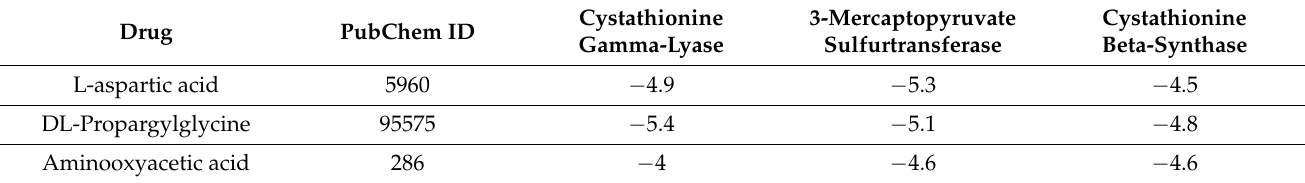
Table 1. The binding energy value (in kcal/mol) of drugs (PAG, L-Asp, and AOAA) to their respective enzymes (CSE, 3-MPST, and AOAA) in the drug docking